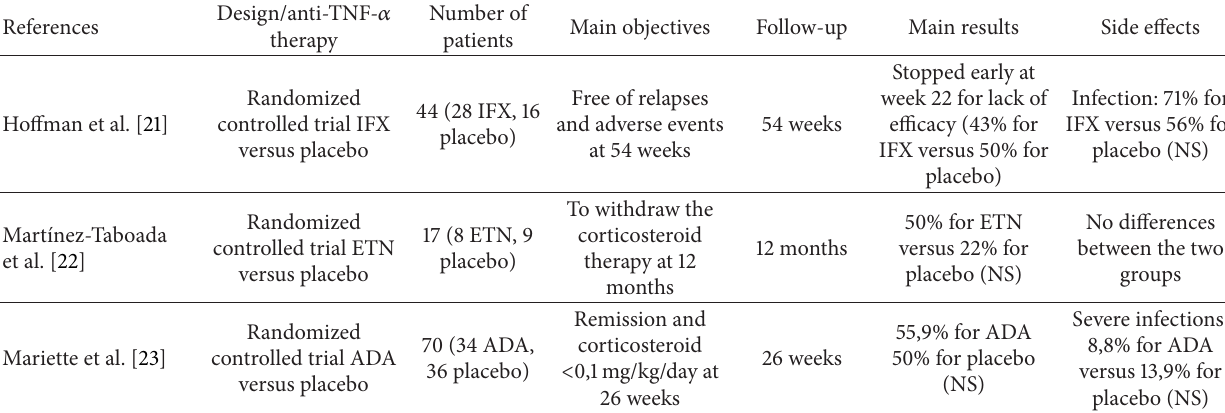
Table 1: Randomized controlled trials performed in GCA.